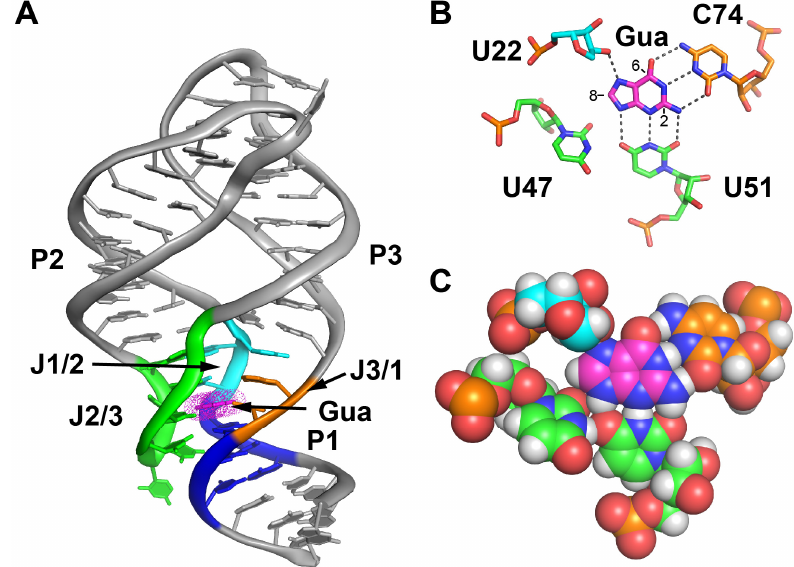
Figure 1. Structure of the guanine-guanine riboswitch (GR) complex ( A ) Ribbon cartoon representation of the global structure of the ligand-RNA complex, with key regions in the ligand binding pocket highlighted in color (helix P1, blue; J1/2, cyan; J2/3, green; J3/1, orange). Guanine is shown in magenta. The same coloring scheme is used throughout. This is from PDB 1Y27 [12]. ( B ) Recognition of guanine by the ligand binding pocket situated in the three-way junction. U51 and C74 form three-hydrogen bond pairing interactions with the guanine ligand. The C8, C6 and C2 positions are denoted on the ligand. ( C ) The same perspective as in panel B, with a Van der Waals spheres to emphasize the space adjacent to the C8, C6 and C2 positions that serves as the starting point for exploring modifications. Hydrogen atoms have been added to fully illustrate the hydrogen bonding interactions.